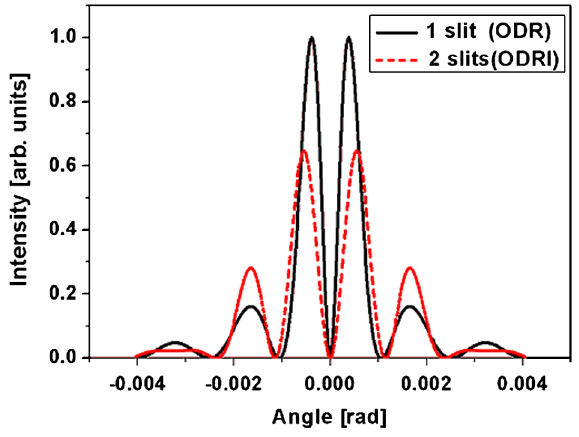
FIG. 2. Comparison between ODR and ODRI angular distri- butions. Parameters of calculation are indicated in the